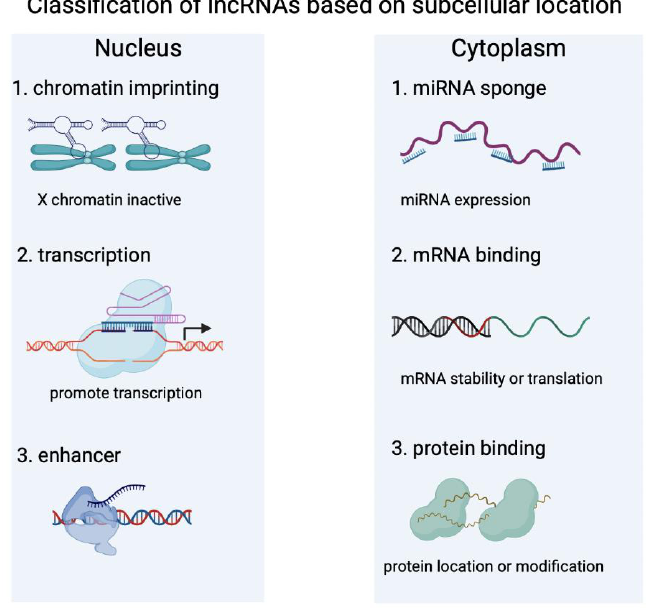
Figure 1. Classification of lncRNAs according to the subcellar localization. LncRNAs resident in the nucleus mainly function through regulating chromatin imprinting, controlling genes at transcriptional or post-transcriptional levels, or serving as enhancers. Cytoplasm-located lncRNAs through binding with proteins or RNAs to regulate miRNAs expression, mRNA stability or translation, and protein modification.